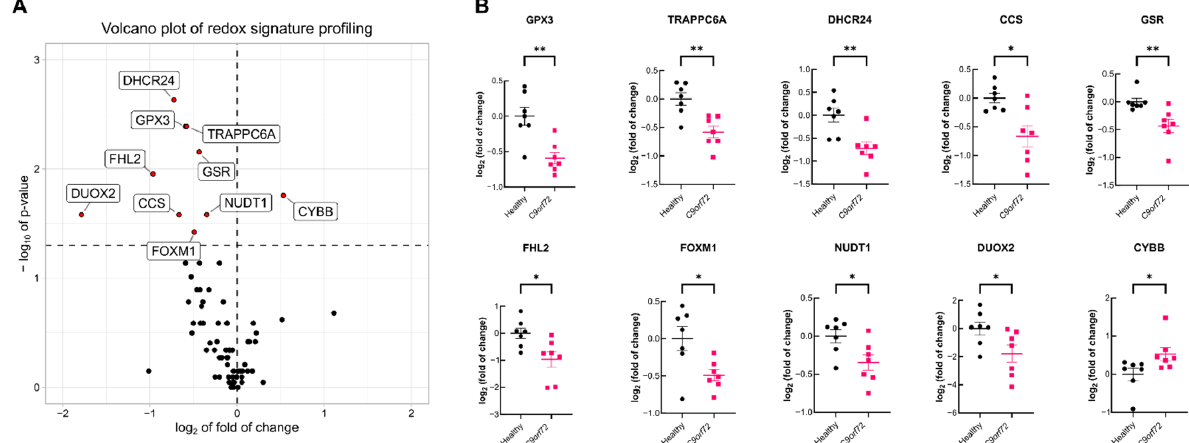
Figure 1. Expression of redox signature is impaired in leukocytes from C9orf72 patients. mRNA levels for redox genes were determined with qRT ‐ PCR in leukocyte RNA from healthy donors ( n = 7) or C9orf72 ALS patients ( n = 7) and normalized using the geometric mean of the levels of the ACTB, B2M, GAPDH, HPRT1 and RPLP0 as housekeeping genes. ( A ) Volcano plot depicting the mean log 2 of the fold of change of each tested gene and − log 10 p ‐ value between C9orf72 and healthy individuals. Horizontal dashed line indicates p < 0.05, and vertical dashed line indicates log 2 fold of change = 0. ( B ) log 2 fold of change of the expression of the genes with statistically significant changes in each individual. Horizontal bars indicate the mean log 2 fold of change value for the mRNA levels in each group and error bars indicate the SEM. Individual points indicate the expression of that gene in each individual. Statistical analysis was performed with the Wilcoxon rank ‐ sum non ‐ parametric test. * p < 0.05; **, p < 0.01 comparing ALS vs. control group.